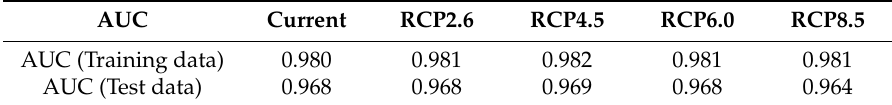
Table 3. Results of receiver operating characteristic (ROC) analysis under current climate and four future scenarios. AUC Current